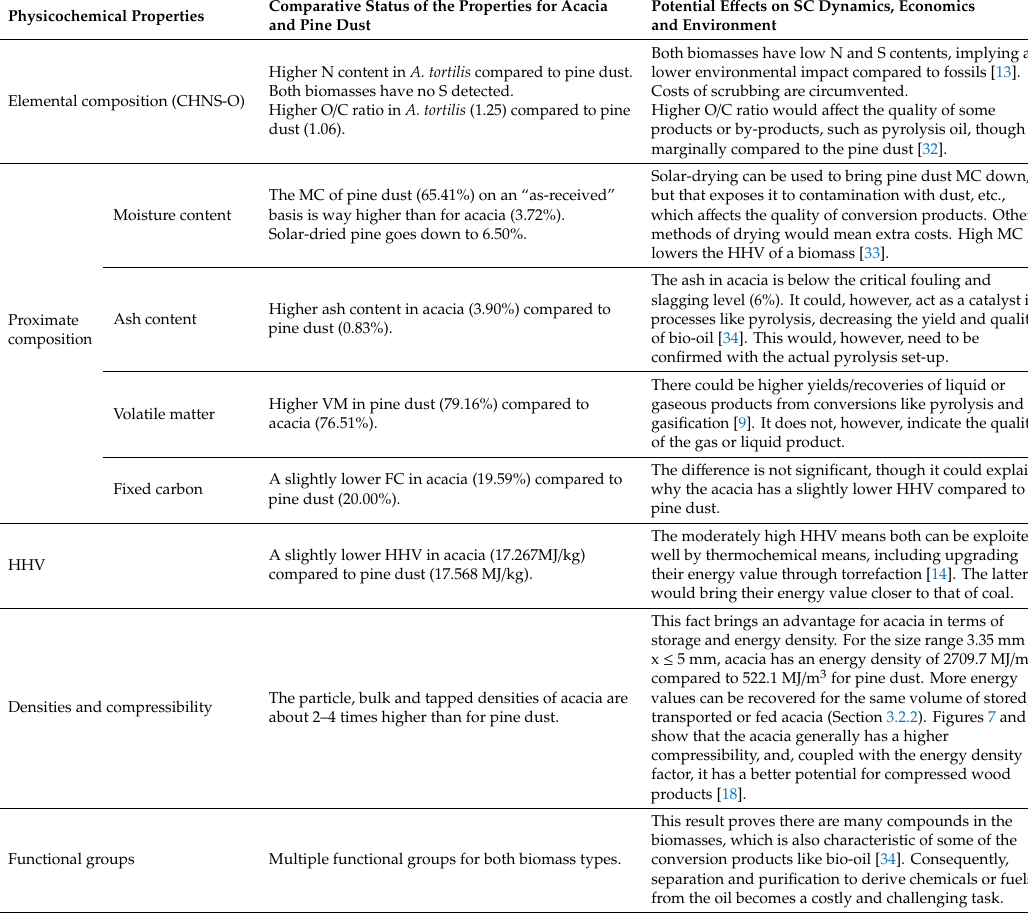
Table 5. The implications of the characterization results on the supply-chain (SC) dynamics, economics and the